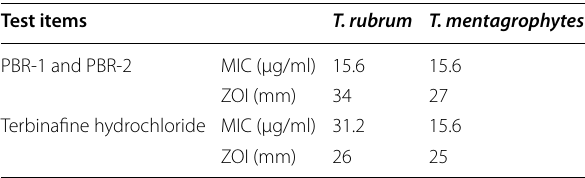
Table 3 MIC/ZOI values of compound PBR-1 and